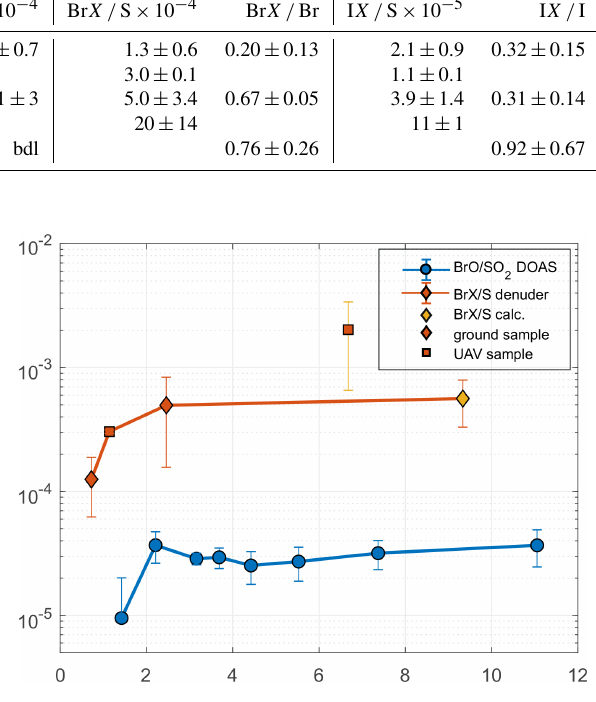
Figure 5. Average RHS/S ratios with plume age: BrO / SO 2 ra- tios measured by a stationary DOAS instrument and Br X / S ratios obtained by ground- and aerial-based denuder sampling; the cal- culated Br X / S value was derived from the Br X / Br ratio at this plume age and Santiago crater rim Br / S value. The UAV sample could be affected by the underestimation of SO 2 (see